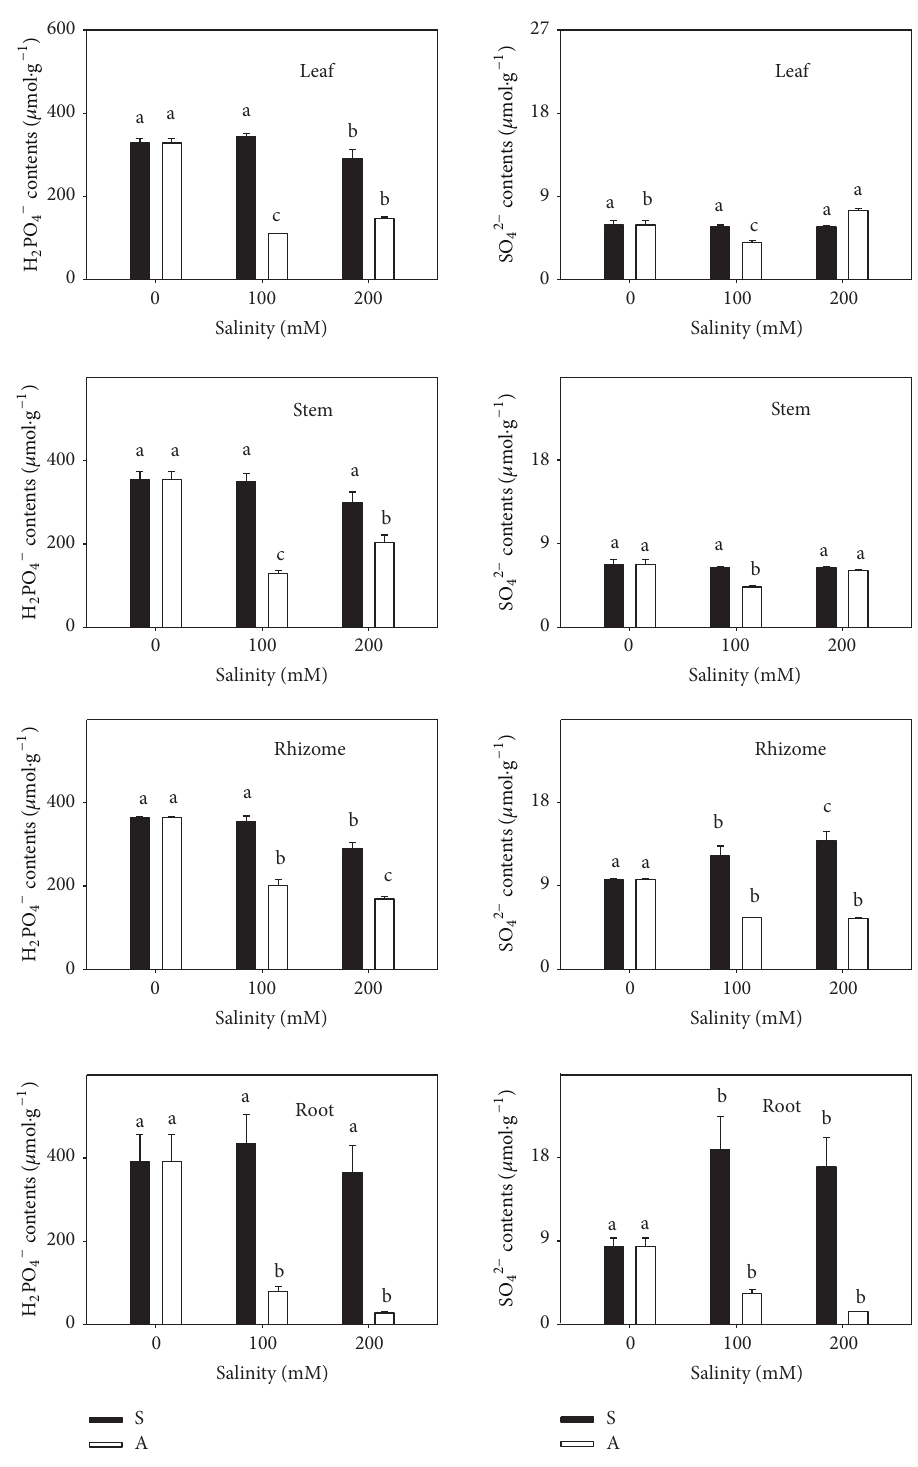
Figure 5: The H 2 PO 4− and SO 42− contents. The effects of salt stress (S) and alkali stress (A) on H 2 PO 4− and SO 42− content in rhizomes, stems, roots, and leaves of L. chinensis . There are three levels under both stresses: 0, 100, and 200mmol/L. The means and standard errors are reported. Within each column, the different letters indicate significant difference among treatments ( 𝑃 < 0.05